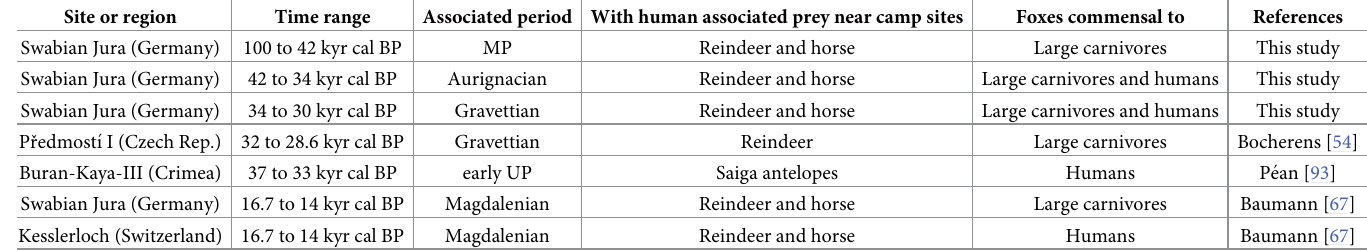
Table 5. Commensal foxes in other archaeological sites.